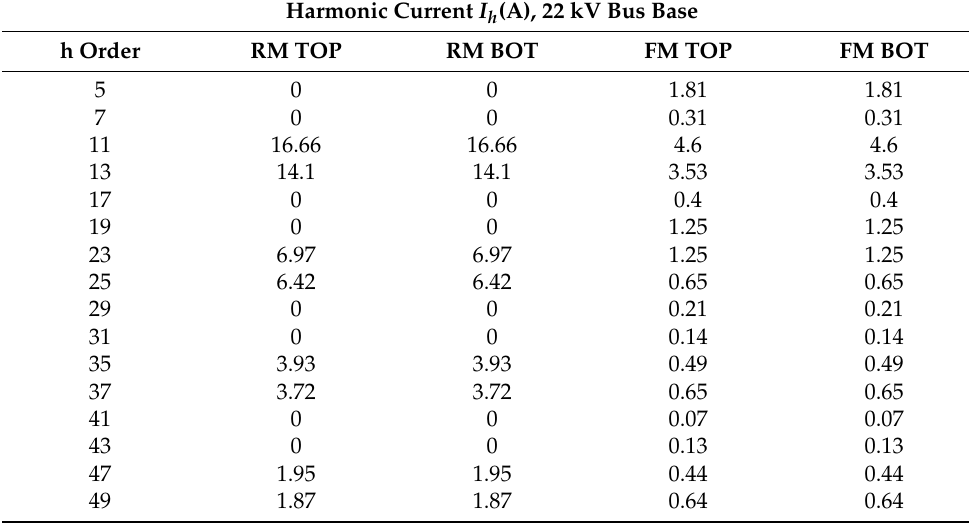
Table 2. Harmonic injection on RM and FM drives.